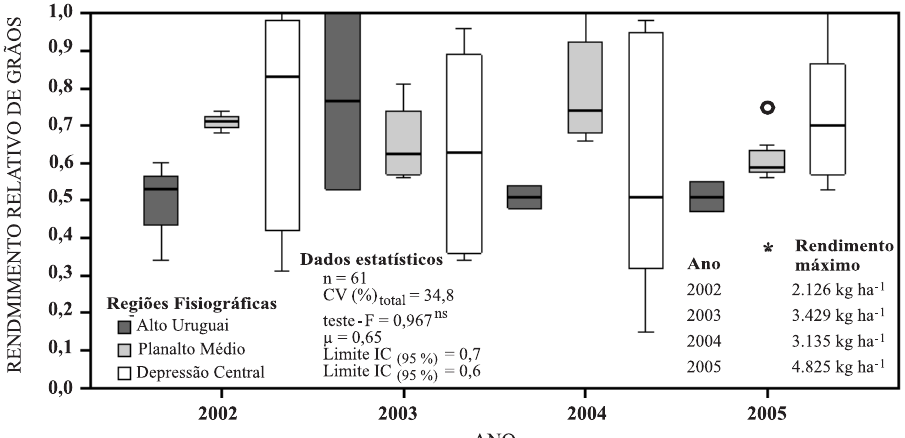
Figura 3. Distribuição do rendimento relativo de grãos de cevada, por Regiões Fisiográficas, ao longo dos anos (ambientes). O rendimento relativo é a razão entre o rendimento absoluto observado em cada ensaio e o rendimento absoluto máximo obtido em cada ano, em todos os